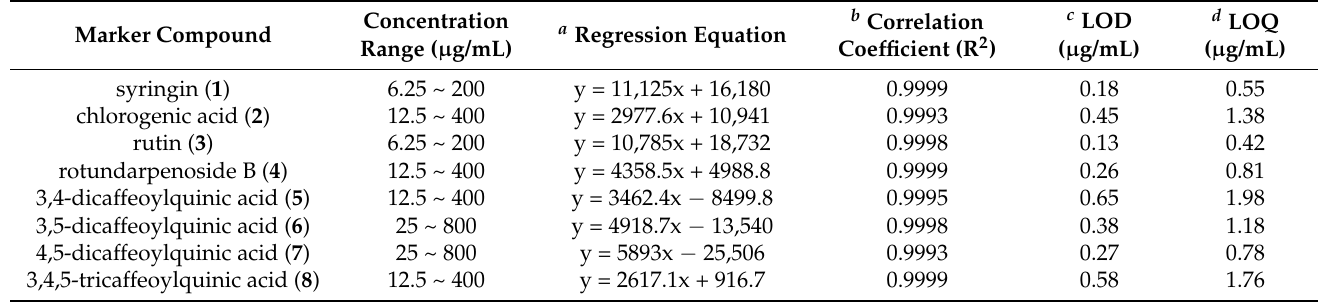
Table 1. Concentration ranges, regression equation, LODs, and LOQs, of the eight marker components in the extract of I. rotunda twigs.